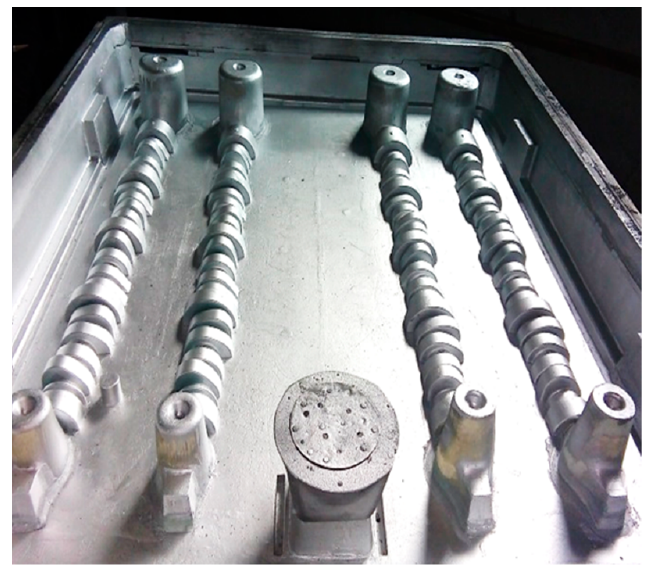
Figure 1. Camshaft tooling containing four camshafts with 16 lobes.